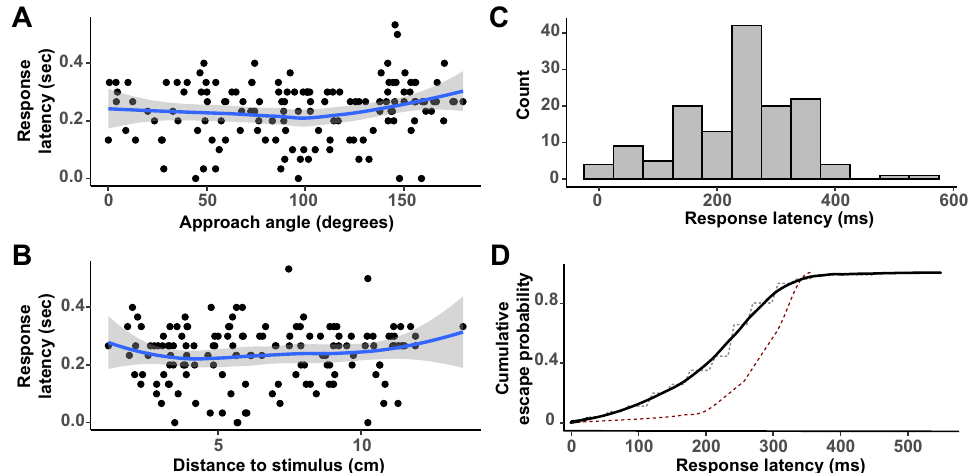
Figure 6. Response latency. Latency associated with the take-off responses of mosquitoes (s) stimulated with a looming square visualized as a function of the (A) approach angle, θ where 0° is to the front of the mosquito and 180° is behind the mosquito (B) distance to the stimulus’ point of introduction (cm). (C) Histogram visualizing the distribution of response latency associated with the take-off responses of 142 mosquitoes. (D) The cumulative probability of take-off in relation to the time since stimulus introduction (black line: smoothed using a local polynomial regression loess ; dashed grey line: raw probability calculated in 10 ms bin increments). For comparison, the dashed red line indicates the cumulative probability of take-off in Drosophila melanogaster (adapted from 20